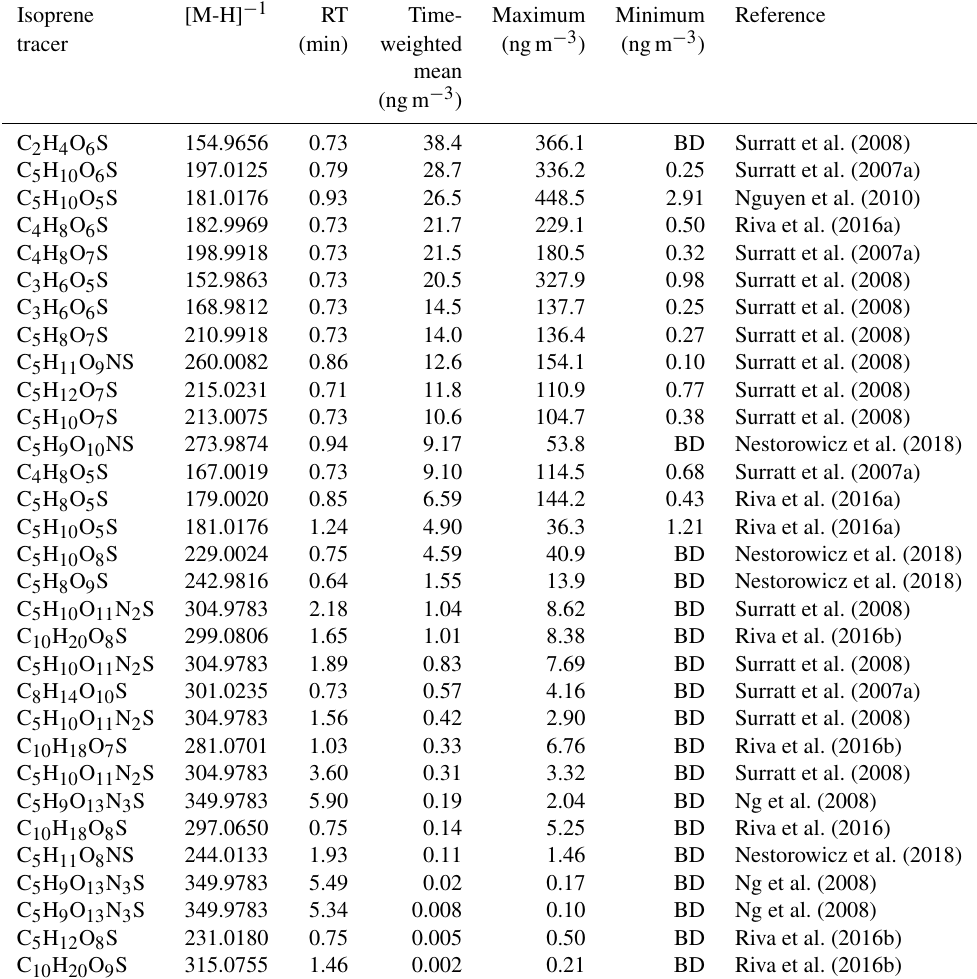
Table 2. Molecular formulas, negative ion masses, retention times (RT) and time-weighted means (ngm − 3 ) for the entire sampling period as well as the original reference where each proposed iSOA tracer was found. BD denotes “below detection”. The estimated uncertainties are 60%, as discussed in Sect. 3.4, accounting for the use of the matrix correction